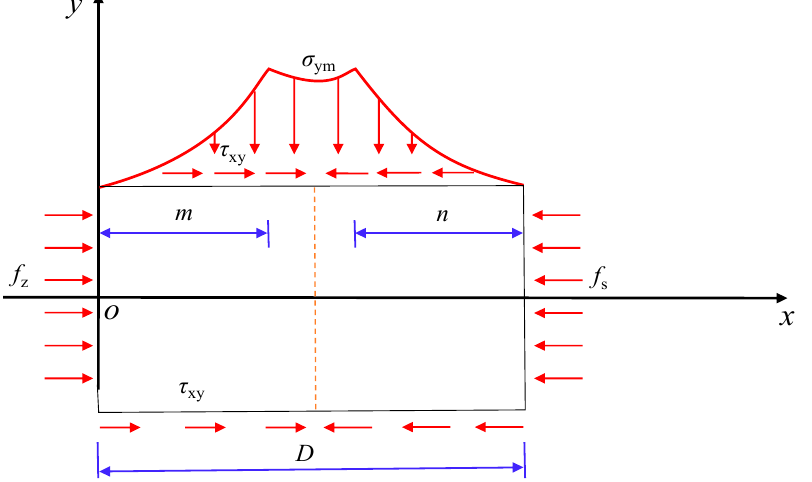
Figure 19. The mechanical model of coal pillar rib [54].